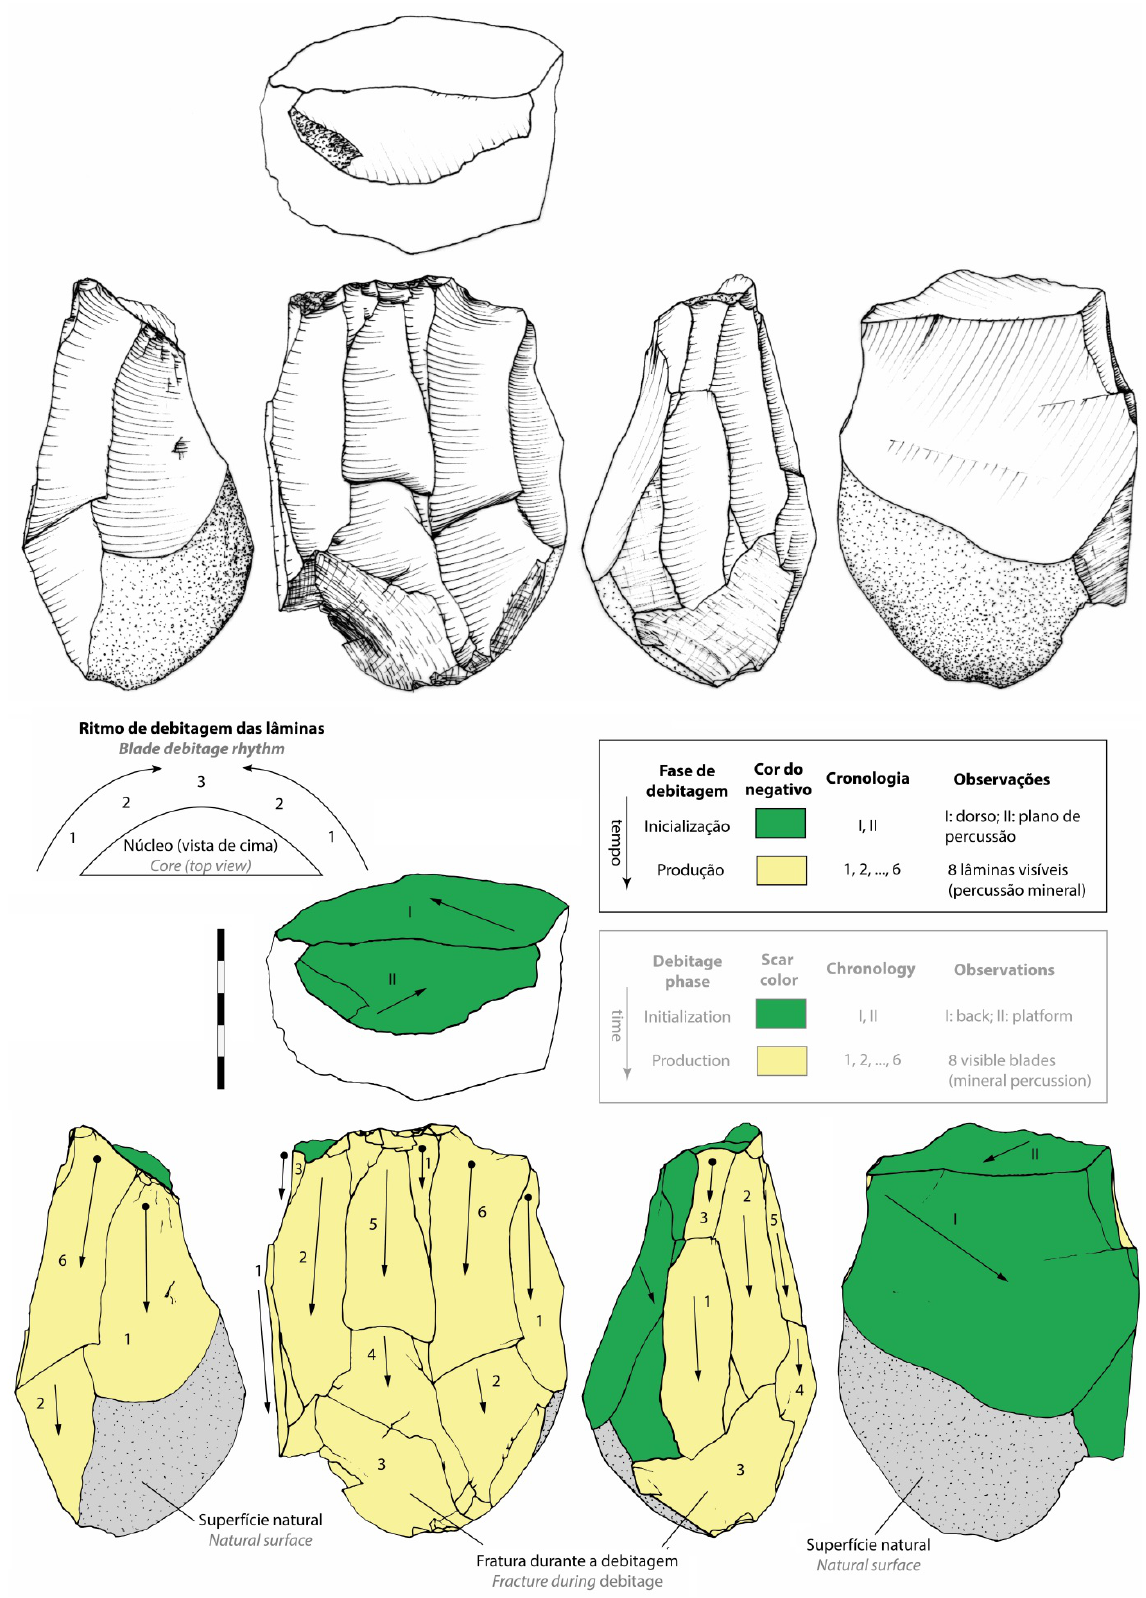
Figura 3. Desenho e esquema diacrítico do núcleo 1, encontrado em ACH-LP-07. Figure 3. Drawing and diacritic scheme of core 1, from